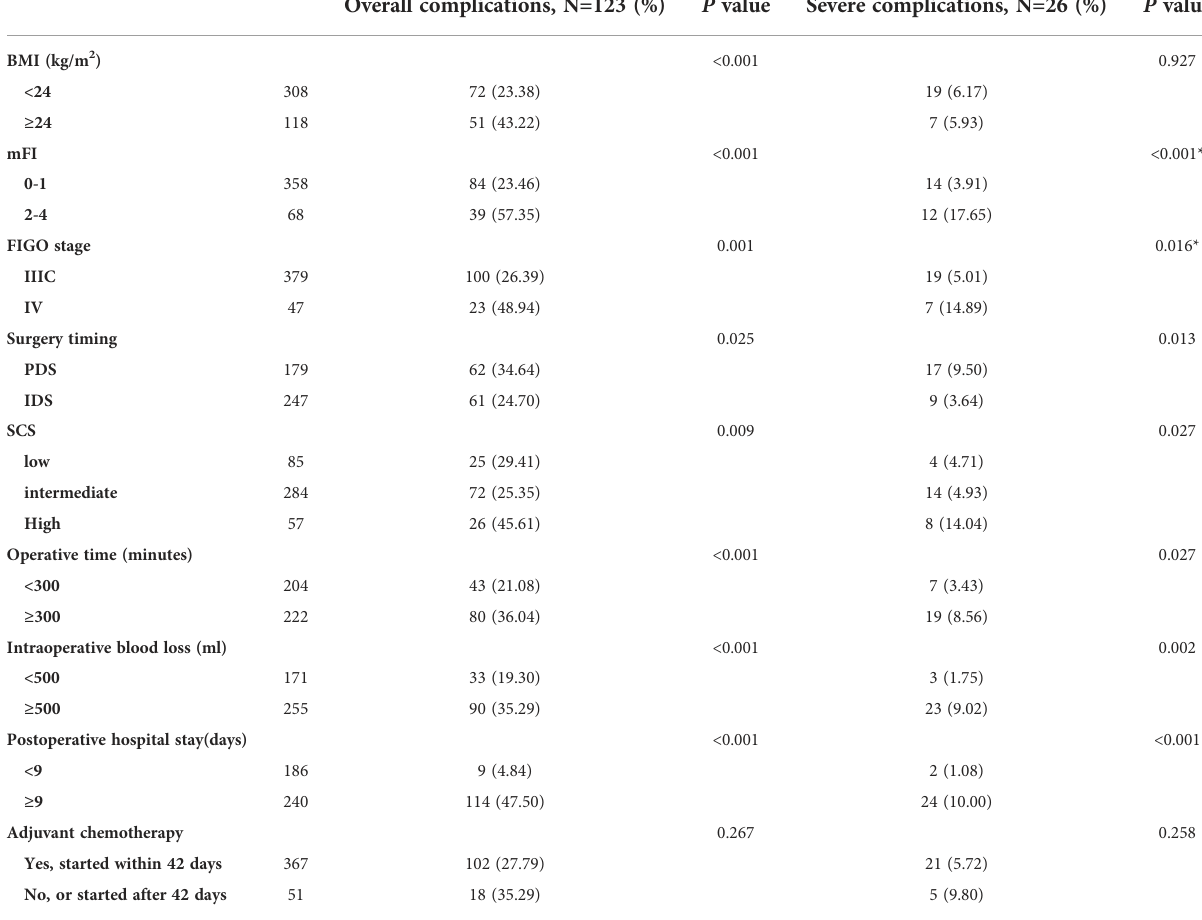
TABLE 2 Comparisons of the overall and severe complications between the